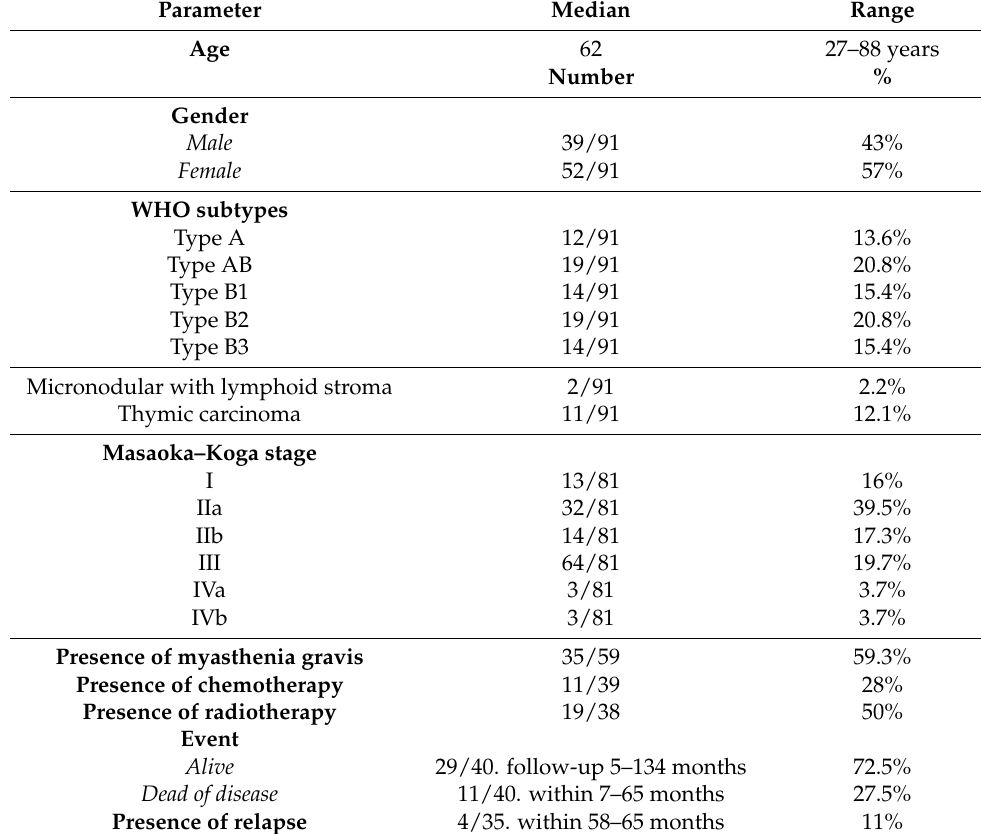
Table 1. Clinicopathological characteristics of 91 patients with